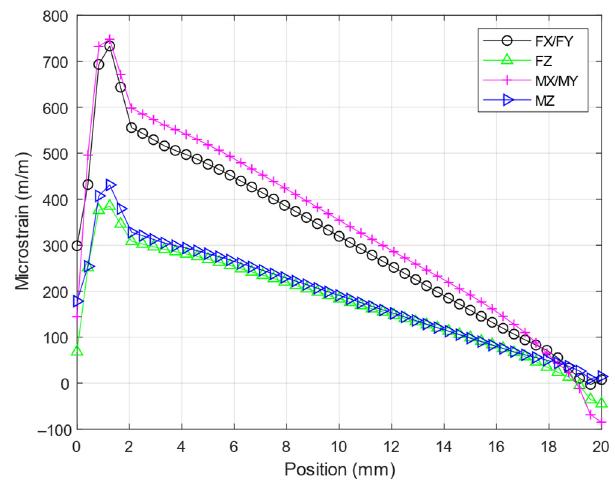
Figure 3. Normal strain analysis on the beam of the elastic body.